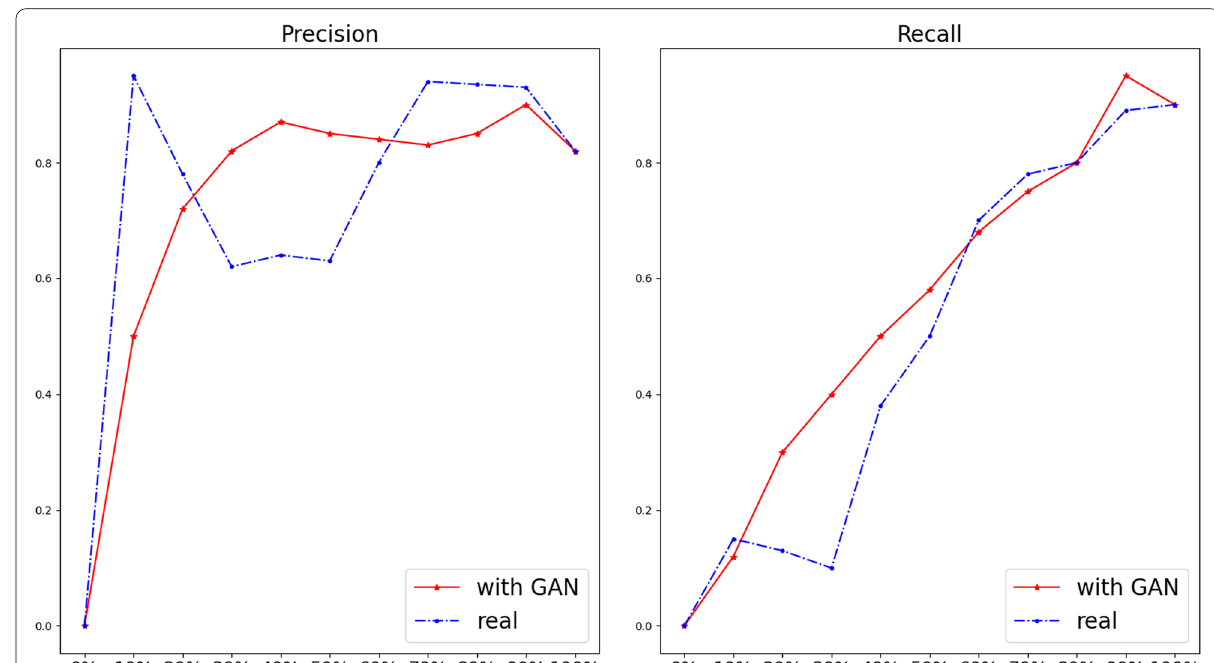
Fig. 6 Comparison precision ( i.e., positive predictive value) and recall ( i.e., sensitivity) between real and added synthetic dataset in different percentages of the training set. The blue and the red lines present the performance of the deep learning classification model trained by real data and the real data plus synthetic data, respectively. The horizontal axis label is the percentage of training data in the dataset. The vertical axis label is the score of precision and the recall with the range from 0 to